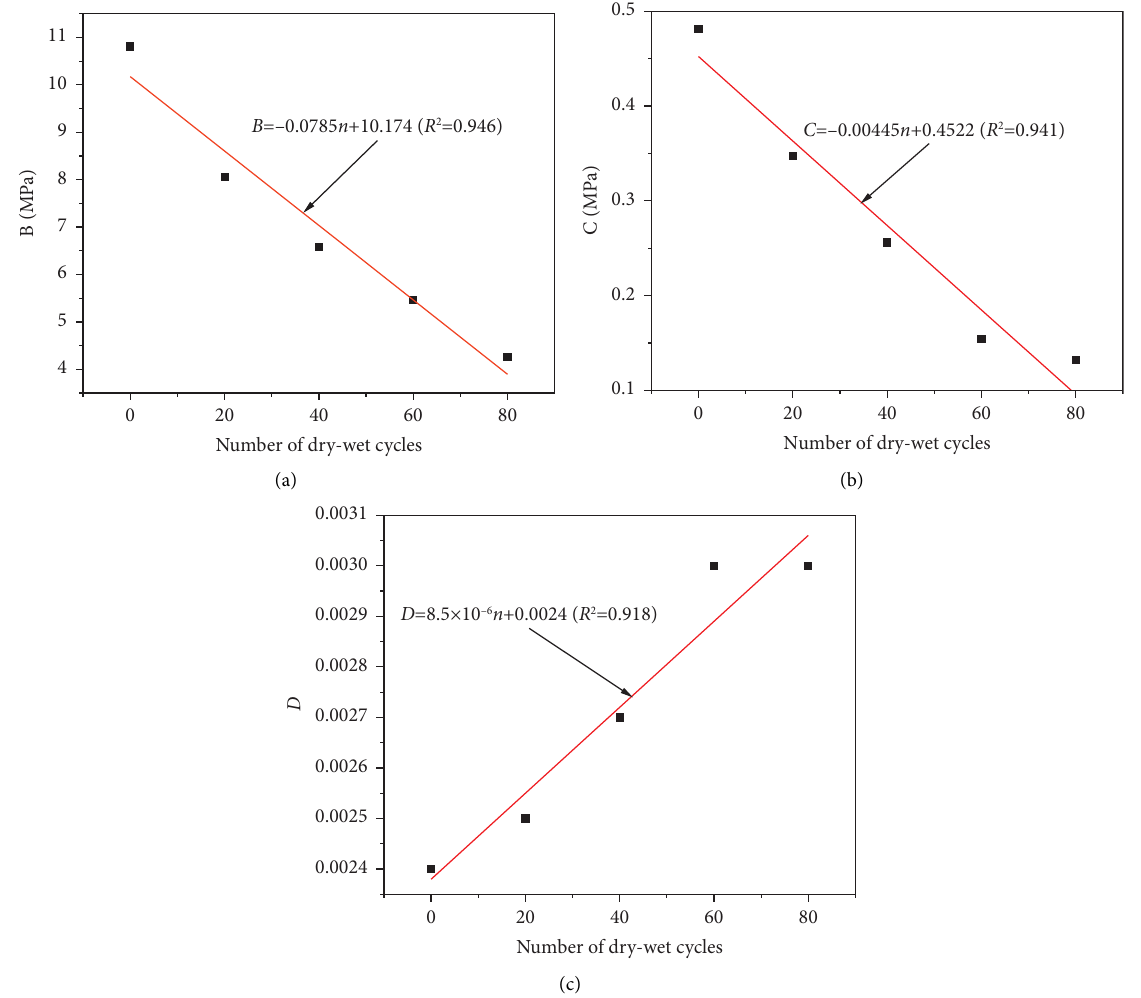
Figure 7: Change law of each parameter versus n : (a) parameter B, (b) parameter C, and (c) parameter